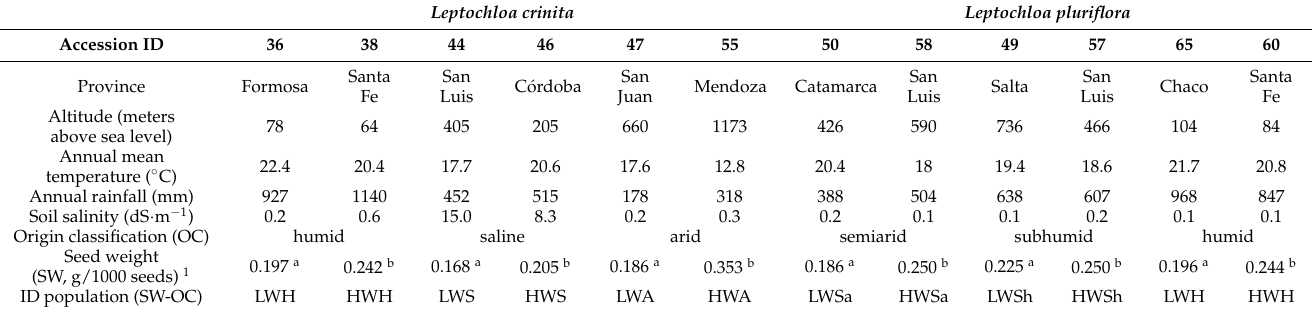
Table 4. Origin and seed weight of Leptochloa crinita and L. pluriflora populations according to the accessions’ passport data of the Leptochloa collection of “Ing. Agr. Jos é . M. Alonso” germplasm bank of the Facultad de Ciencias Agrarias of the Universidad Nacional del Litoral. Leptochloa